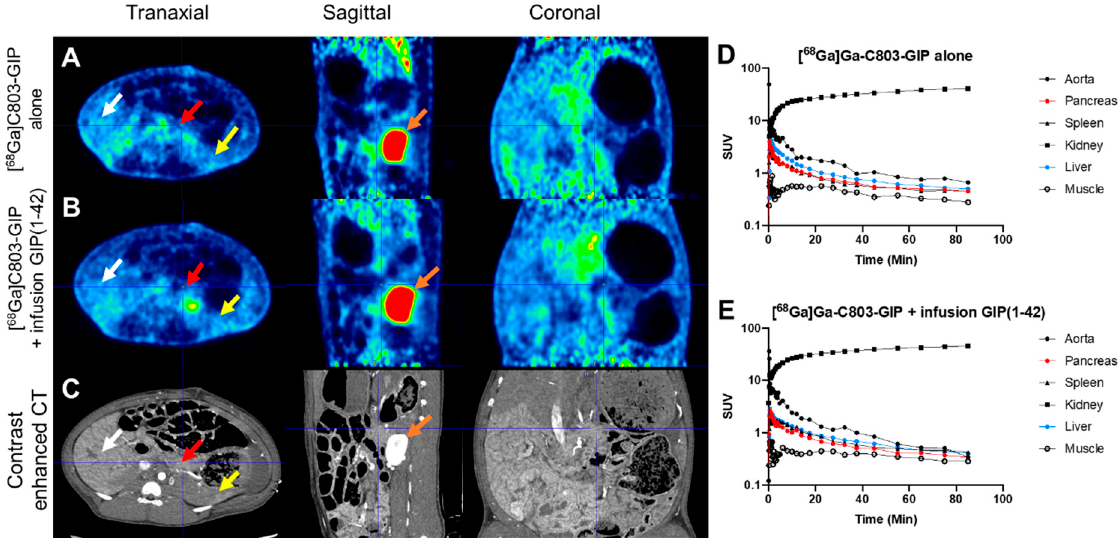
Figure 7. PET/CT images of the abdomen of pig following administration of [ 68 Ga]Ga-C803-GIP, either tracer alone ( A ) or during infusion of GIP(1-42) ( B ). Anatomical reference by contrast enhanced CT ( C ). White arrows indicate liver, red arrows indicate pancreas, orange arrows indicate kidney, and yellow arrows indicate spleen. Images are normalized to SUV = 2 and are summations 60–90 min after tracer administration. Time-dependent kinetics in relevant tissues are presented after administration of [ 68 Ga]Ga-C803-GIP alone ( D ) or during intravenous infusion of GIP(1-42) ( E